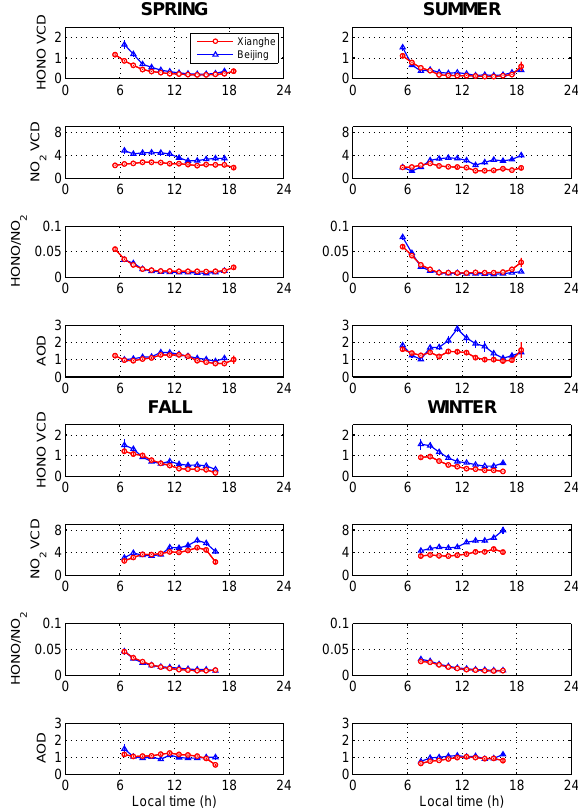
Fig. 12. Same as Fig. 11 but for the vertical column densities (VCDs) and aerosol optical depths (AODs). HONO and NO 2 VCDs are in × 10 15 and × 10 16 moleccm − 2 units, respectively. The corre- sponding diurnal variations of the AOD are also